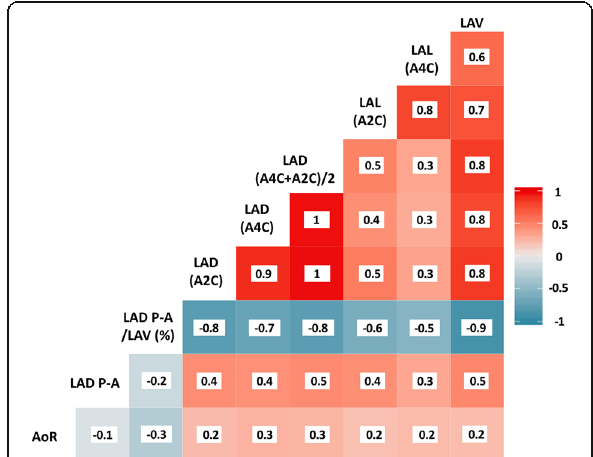
Fig. 2 All of the echocardiographic parameters used to assess the LA size were plotted against AoR. Shown are the Pearson correlation coefficients (r values). The color code was generated to evaluate the degree of correlation (white to red = 0 to 1; white to blue = 0 to − 1). LAL (A4C) and LAL (A2C) indicate the LA length from apical 4 and apical 2 chambers, respectively; LAD (A4C +A2C)/2 indicates the average of LA diameter assessed in apical 4 and apical 2 chambers; LAD (A4C) and LAD (A2C) indicate the LA diameter assessed in apical 4 and apical 2 chambers, respectively; LAD P-A/LAV (%) indicates the ratio of LAD P-A to LAV